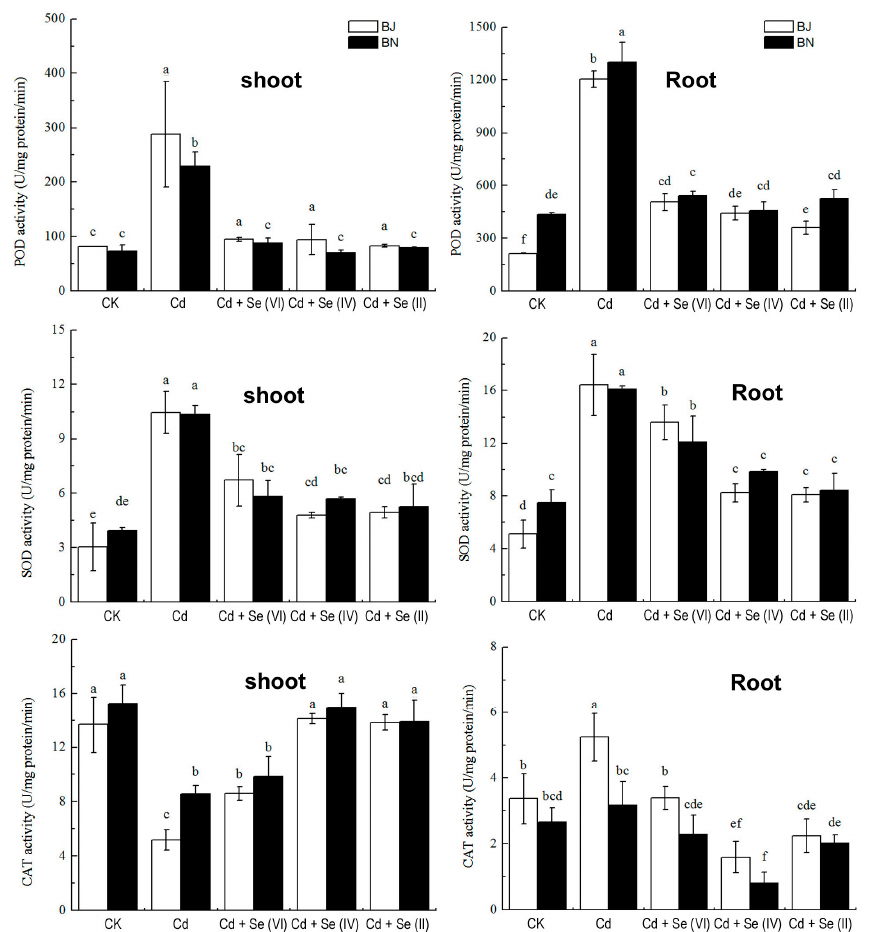
Figure 4. Effects of Cd and exogenous Se application on the superoxide dismutase (SOD), peroxidase (POD) and catalase (CAT) in the shoot and root of two Brassica species. All values were means ± SD ( n = 3). Different small letters indicate significant difference at P <